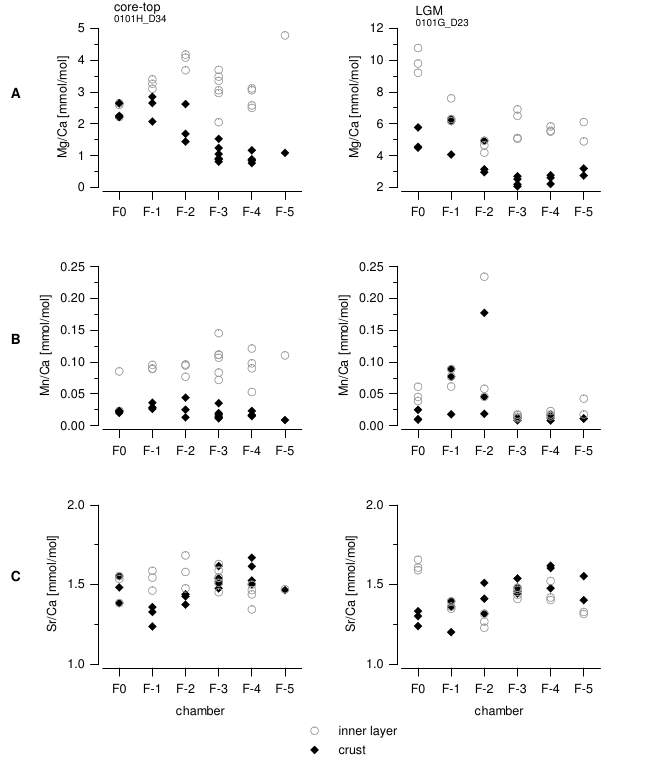
Fig. 5. Intra-test trace element variability in N. dutertrei , examples from a core top (left) and an LGM (right) specimen from sediments from the SE South African margin. (A) Mg/Ca; (B) Mn/Ca and (C) Sr/Ca ratios for individual chambers. Symbols as in Fig. 4.